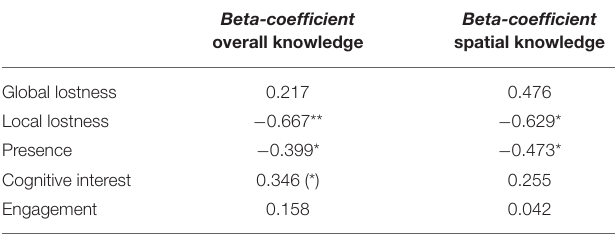
TABLE 7 | Beta-coefficients between knowledge, lostness, and experience measures from the combined